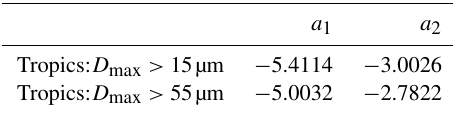
Figure 28. Probability distribution function of rescaled PSD ( (cid:56) 2 , 3 ) on the y axis as a function of hydrometeor characteristics size ( x ) on the x axis for the merged datasets. The black lines show fitted func- tions from Field et al. (2007), the dotted grey lines show the median rescaled PSD with an error bar from the 25th and 75th percentiles of rescaled PSD. The solid white line shows the new fitted function for the merged dataset for PSD beyond 55µm, and the dashed white line shows the fitted function for PSD beyond 15µm (Eq. 24). Table 1. Coefficients a 1 and a 2 for Eq.